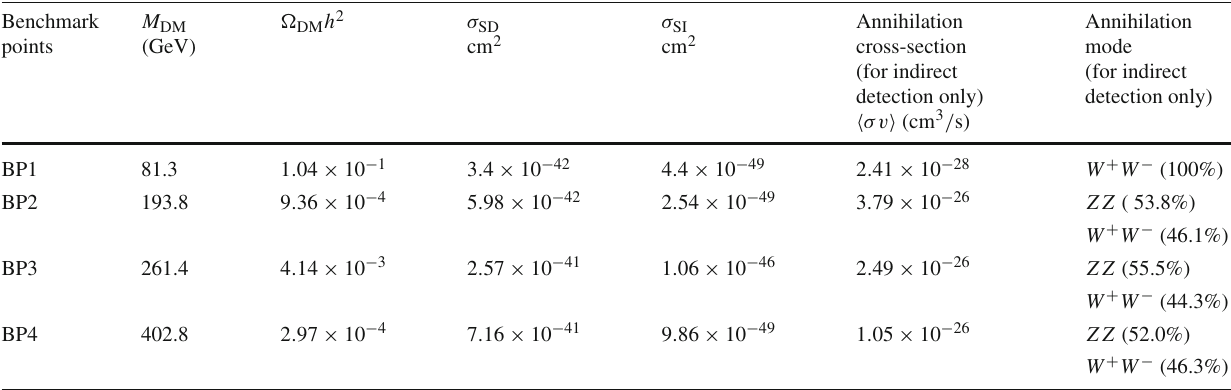
Table 4 DM masses along with DM relic density, spin-dependent, spin-independent cross-sections, thermally averaged indirect detection annihi- lation cross-sections and corresponding dominant annihilation modes for four